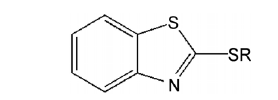
Fig. 1 The structural formula of the compound.